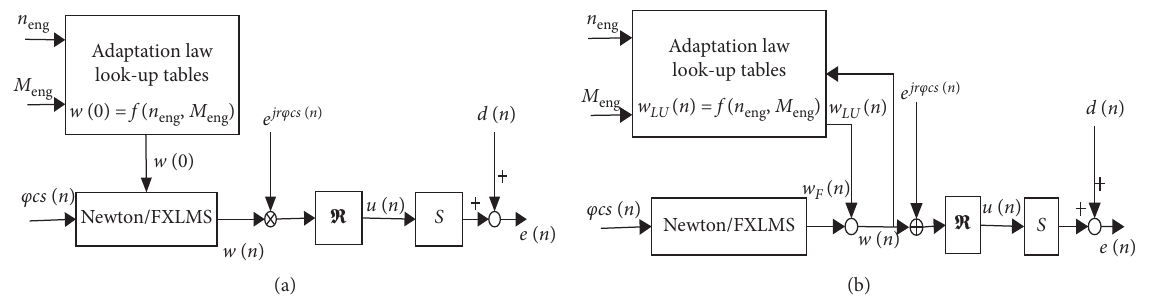
Figure 15: Newton FXLMS with look-up tables [3, 134, 153]: (a) Newton FXLMS with parameter-map; (b) Newton FXLMS with parallel-